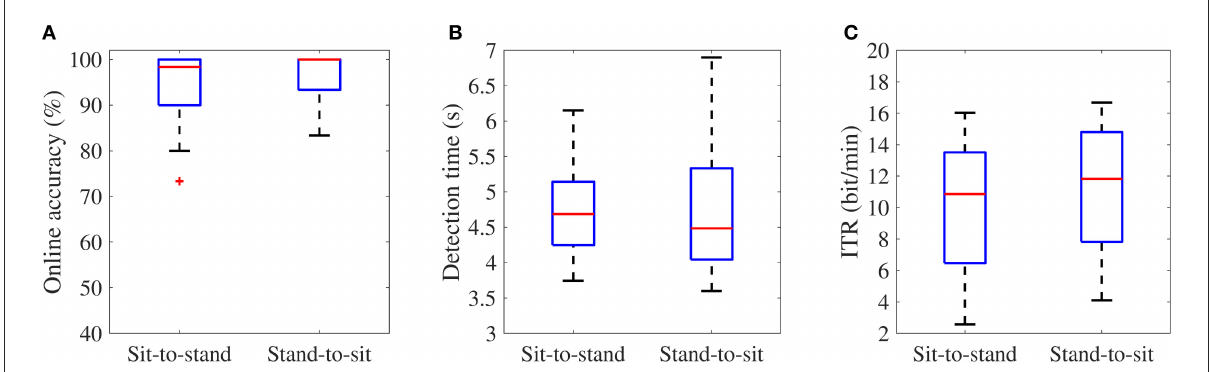
FIGURE9 Box plots of the online accuracy (A) , task detection time (B) , and ITR values (C) of the BCI online experiments. The Supplementary material section provides the result for each participant.